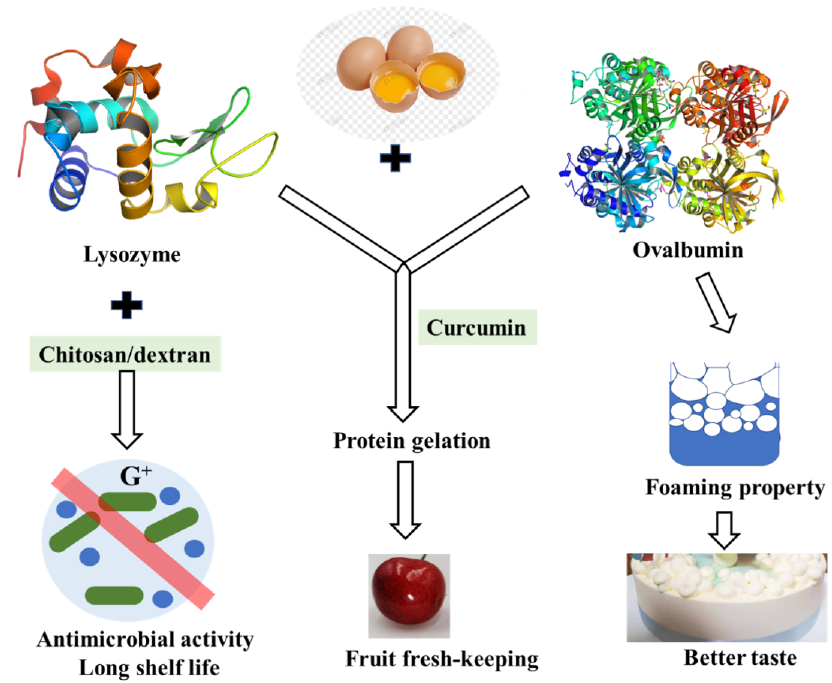
Figure 5. Functional proteins in eggs and their contribution to shelf-life and taste of